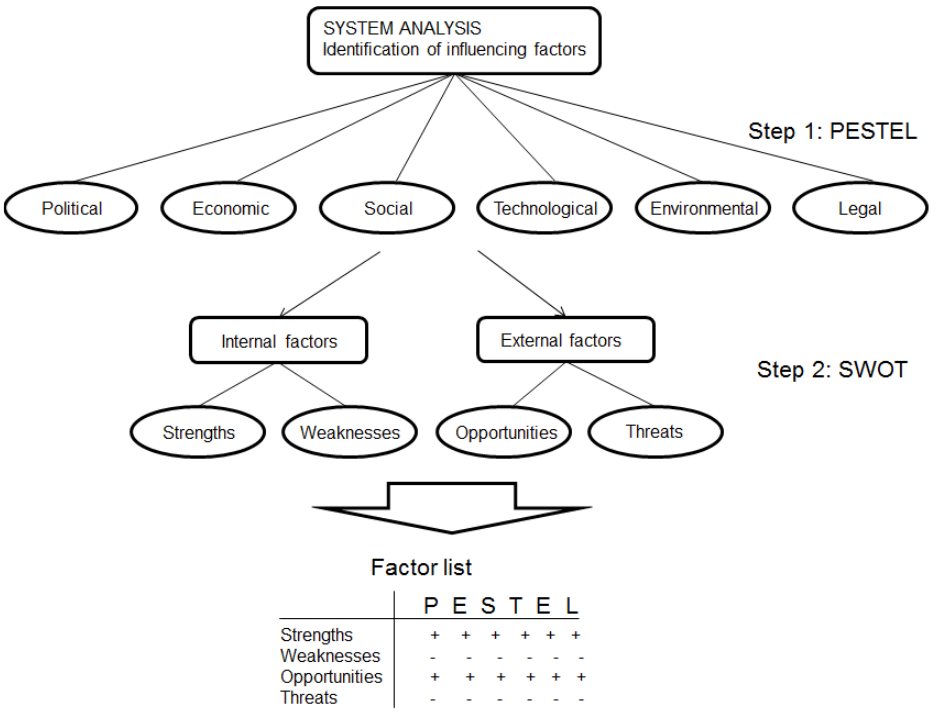
Figure 2. A scheme of a sequential PESTEL and SWOT analysis used in this study, modified from Srdjevic et al. [32] by the first author.